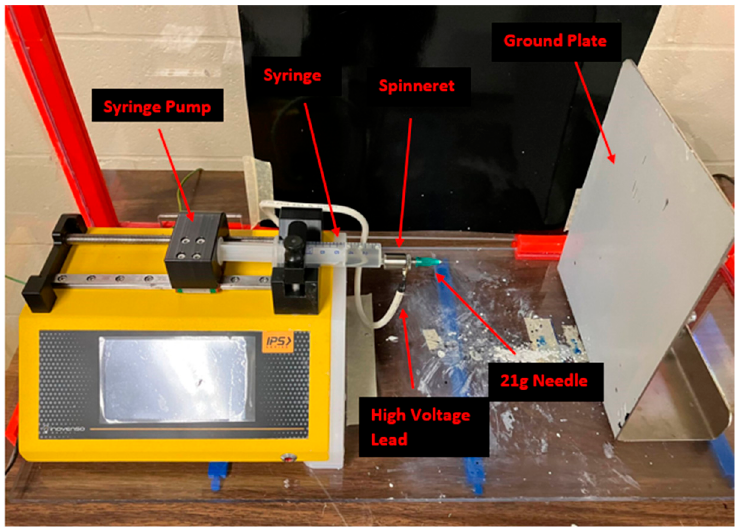
Figure 1. Electrospinning apparatus.